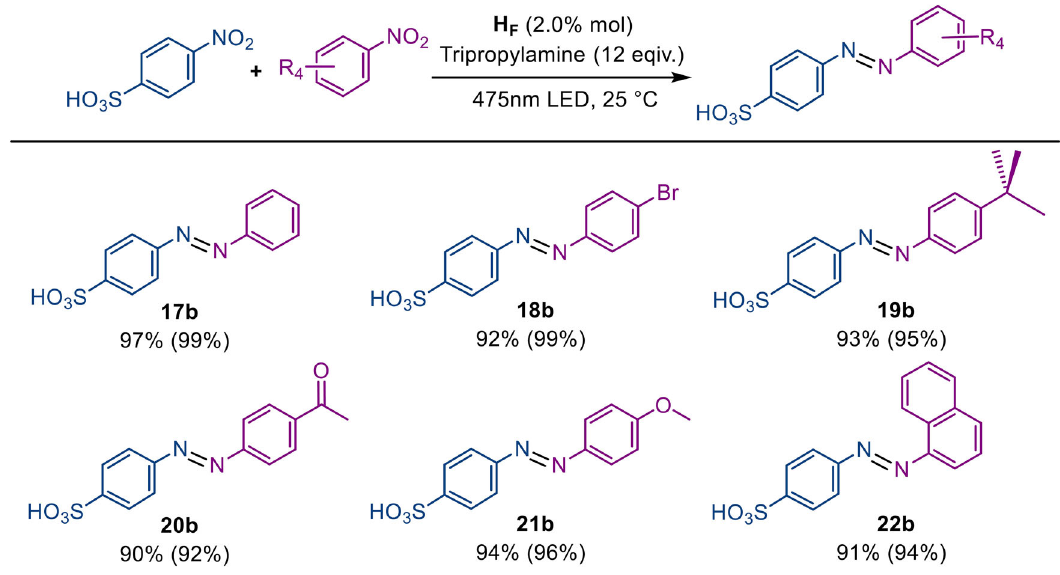
Fig. 9 Scope of selective conversion of asymmetric azo compounds. Isolated yields are reported with the selectivity in parentheses. Standard conditions for asymmetric azo product conversion: 2.0 mol% H F , two substrates with equimolar amounts (0.025 mmol) and tripropylamine (0.60 mmol) under light irradiation for 6